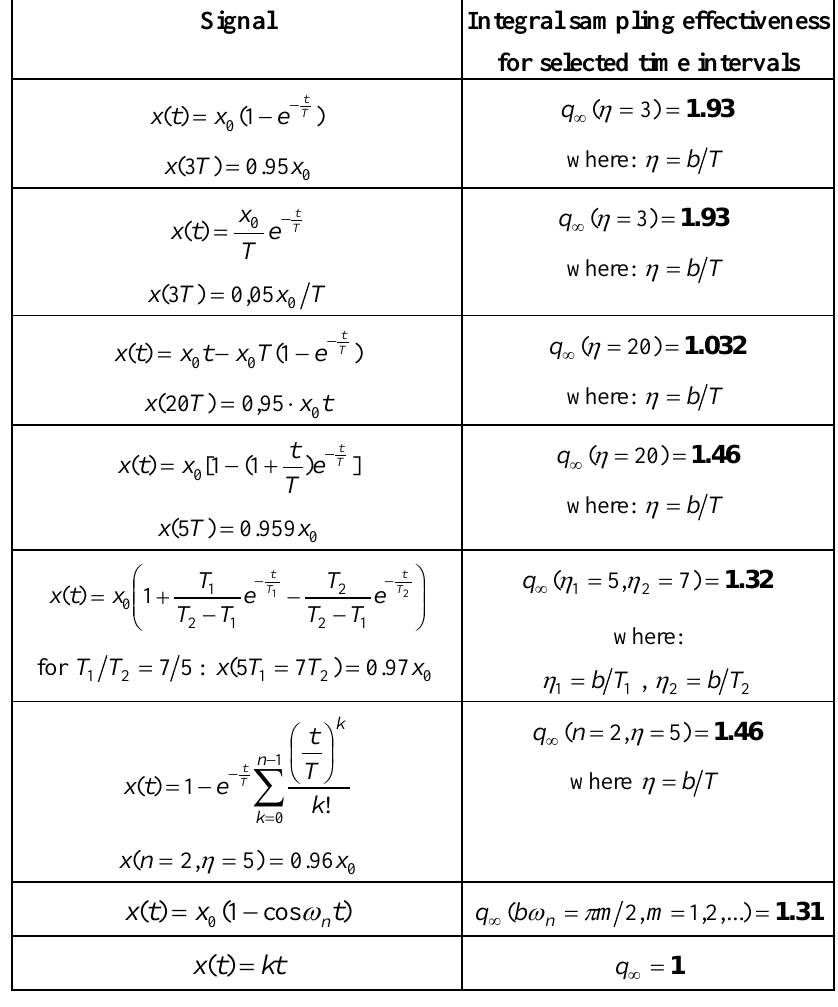
Table 4 . The event-based integral sampling asymptotic effectiveness for selected time intervals ],0[ b . Signal Integral sampling effectiveness for selected time